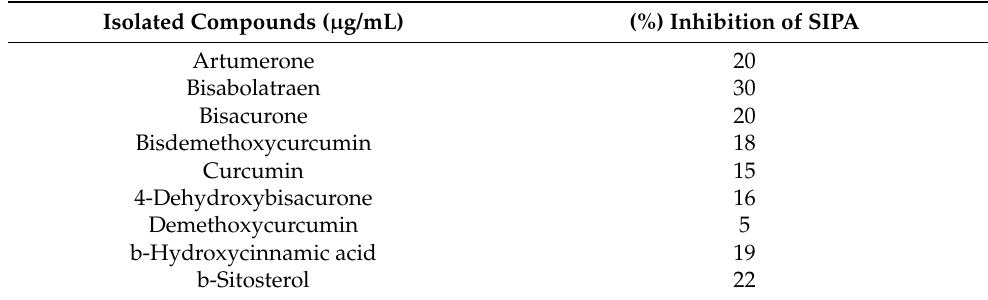
Table 7. Inhibitory effects of curcuminoids and curcumin on rat PRP aggregation [132].